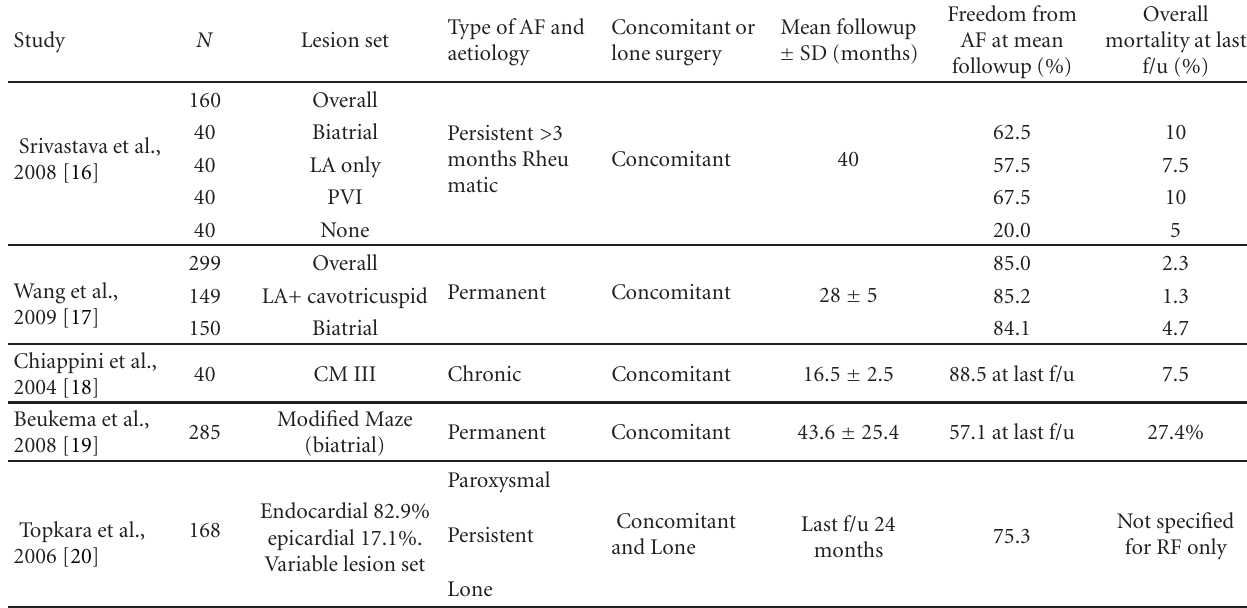
Table 2: Summary of results obtained by radiofrequency